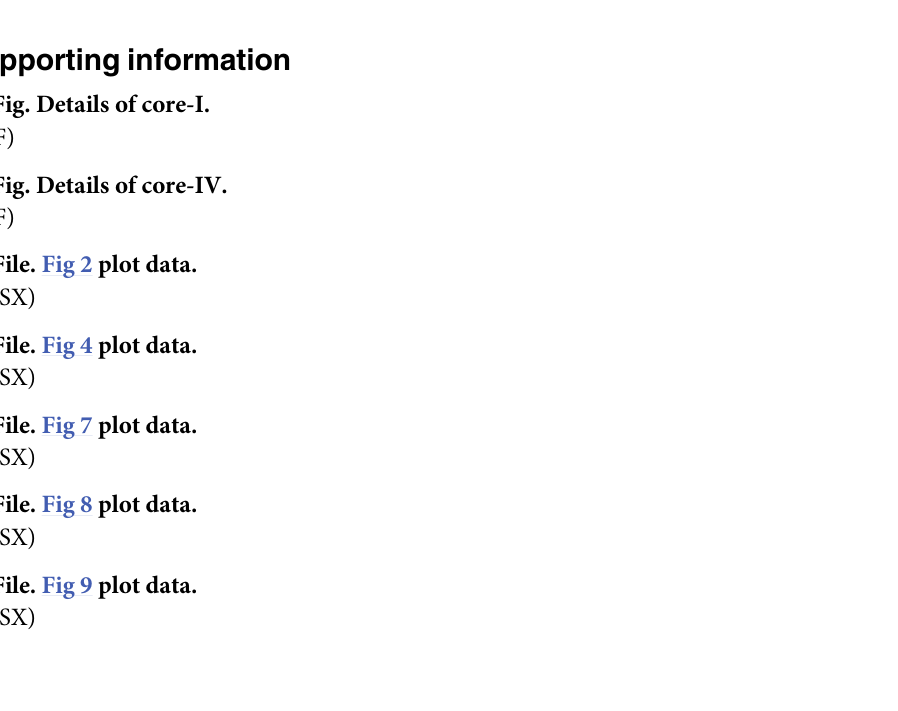
S1 Fig. Details of core-I.